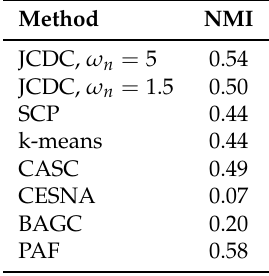
Table 1. The NMI results of eight community detection methods for the multi-layer attributed network with m ∗ = 3 network layers and p = 6 attribute